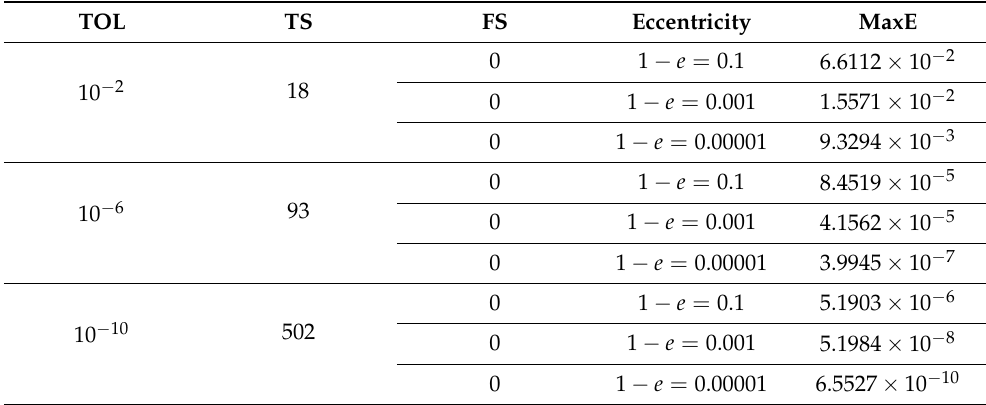
Table 5. Performance of the VSHBM on Kepler problem at different eccentricities and run time (cid:2) (cid:3) t ∈ 0, 10 8 .